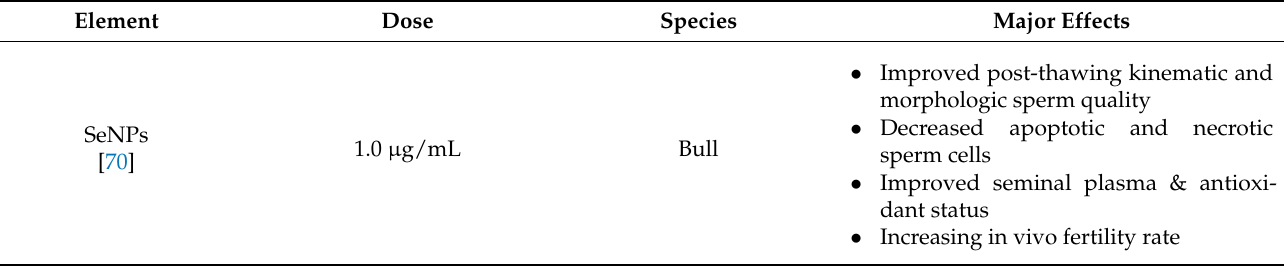
Table 2. Effect of nanominerals on the ruminant’s